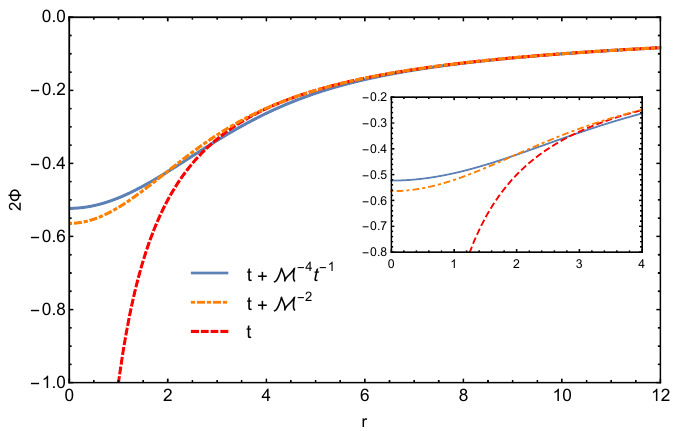
Figure 1 . The nonlocal gravitational potential (blue solid line, t + M (cid:0) 4 t (cid:0) 1 ) generated by a point-like source in the nonlocal theory described by the action (3.16) and corresponding to the choice (2.6) with M 0 = 1 , compared to the Newtonian potential (red dashed line, t ) and to the nonlocal potential corresponding to the choice (2.2) of the proper-time function (orange dotted- dashed line, t + M (cid:0) 2 ). Here we set G = 1 = M and m = 0 :